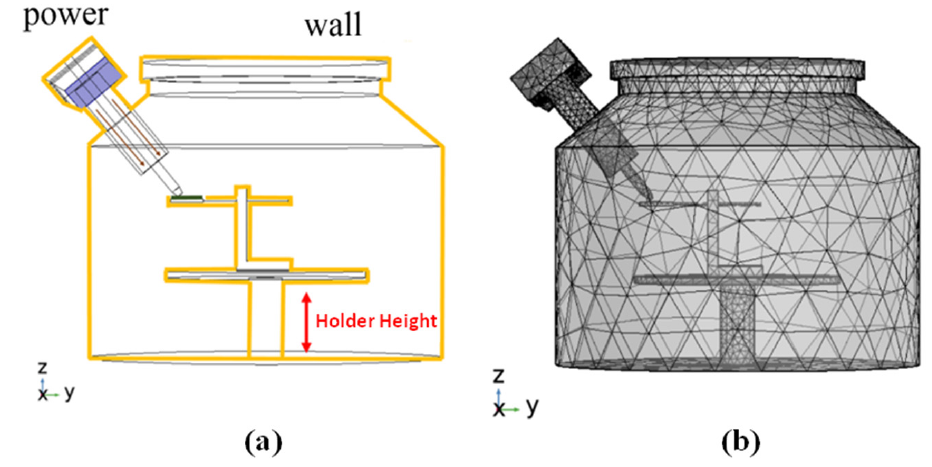
Figure 4. ( a ) Reactor geometry and ( b ) the FEM adaptive meshing of the MPJCVD system.